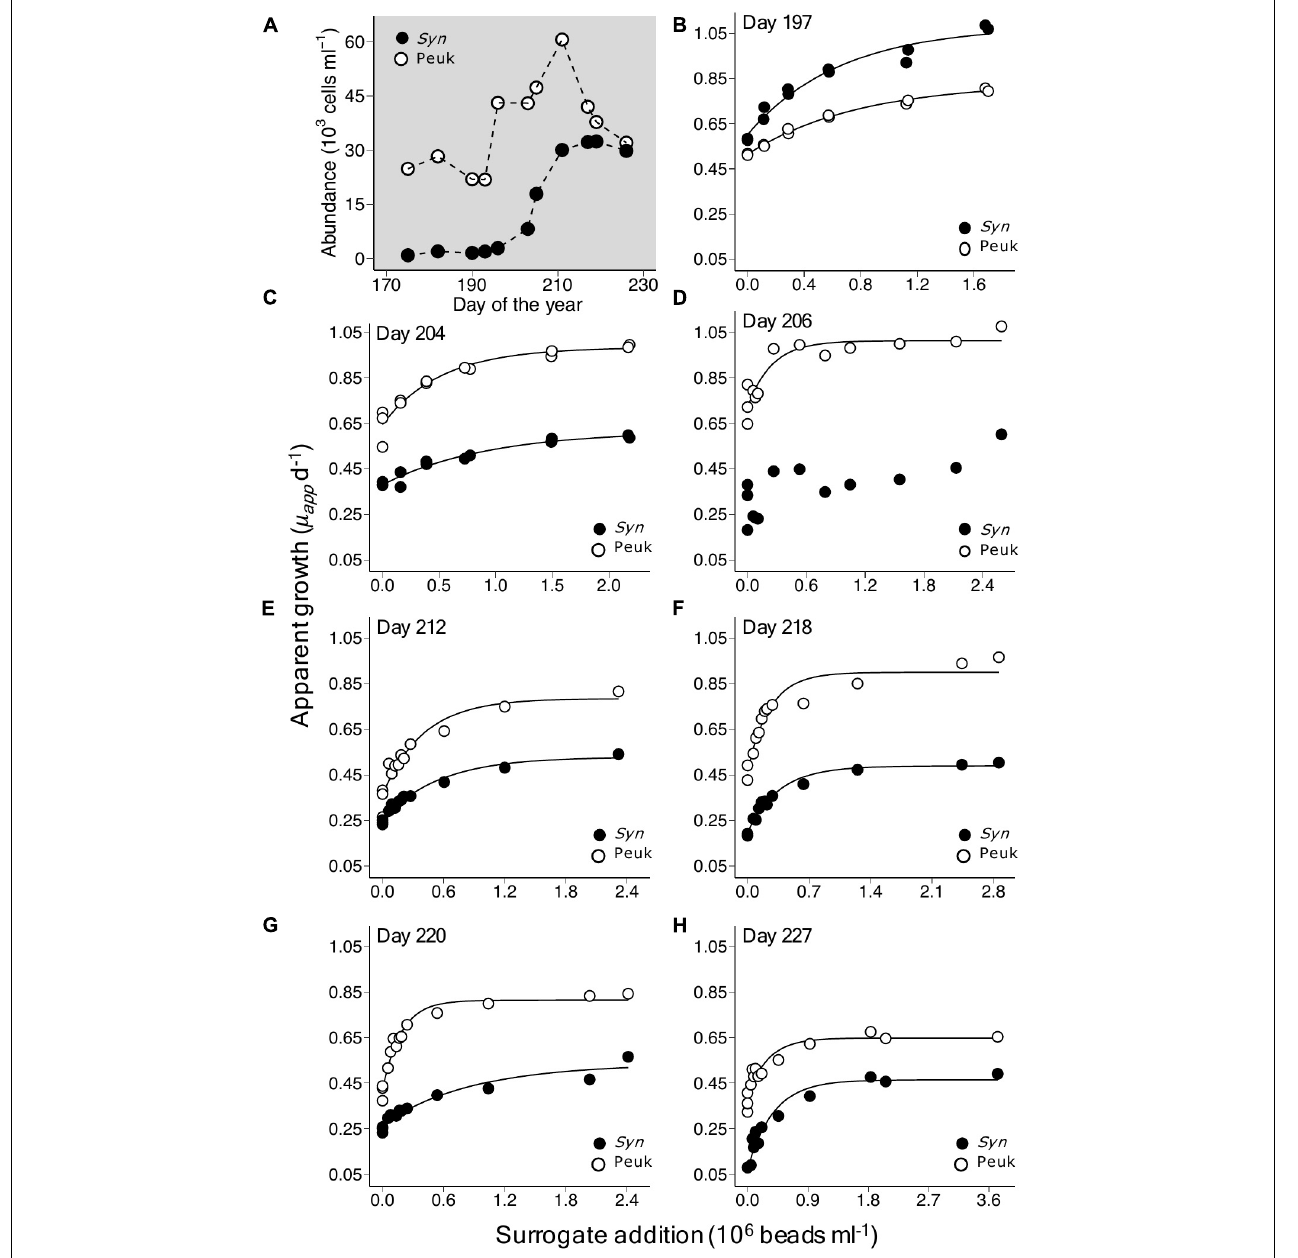
FIGURE 2 | Growth response in populations of picoeukaryotes and Synechococcus in a series of saturation experiments using coastal waters of the Gulf of Maine during July and August, 2019. (A) Shows changes in abundance of the two taxonomic groups during this period. Plots (B–H) show the apparent growth rate ( µ app ) vs. surrogate prey addition, with corresponding asymptotic regression fits, in experiments conducted between days of year 197 and 227, details of which are shown in Table 2 . these periods of maximal in situ net growth, the µ net values